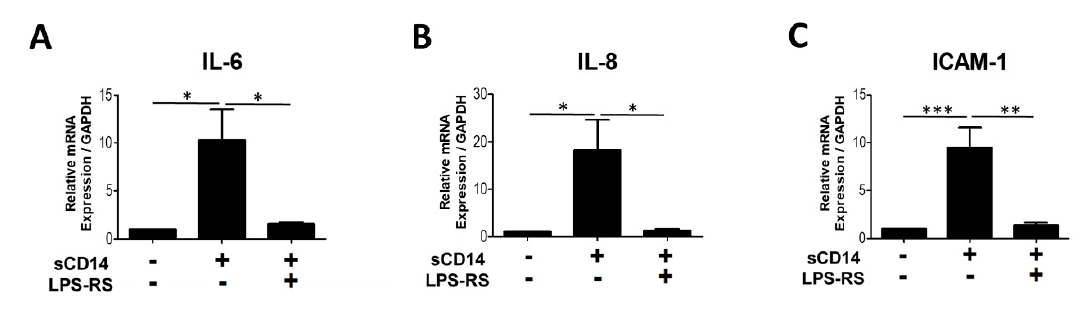
Figure 4. LPS-RS, an antagonist of TLR-4, abolishes sCD14-induced IL-6, IL-8, and ICAM-1 expression on RA-FLS. RA-FLS were cultured with sCD14 (500 ng / mL), in the absence or presence of LPS-RS (2 ug / mL, 1 h pretreatment), for 3 h. Relative expression levels of IL-6 ( A ), IL-8 ( B ), and ICAM-1 ( C ) mRNA were measured by real-time PCR, and their levels were normalized to GAPDH mRNA. Data are shown as means ± SEM in five RA-FLS. Statistical significance was analyzed by Tukey’s Multiple Comparison Test (* p < 0.05, ** p < 0.01, and *** p < 0.001).